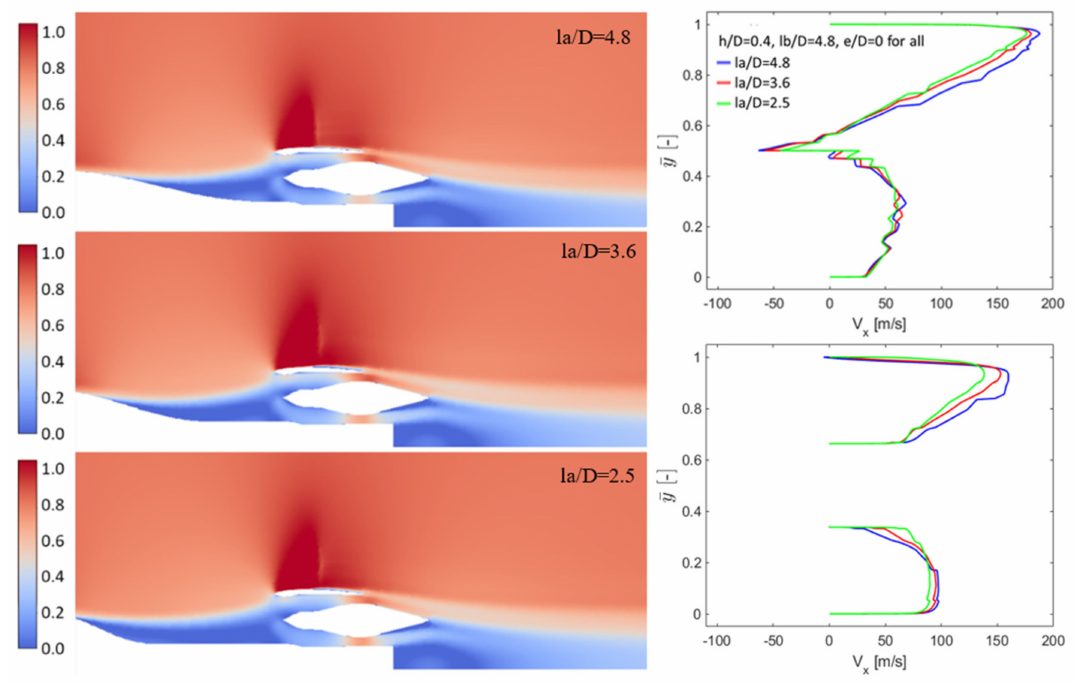
Figure 9. Contours of Mach number. Results of varying intake diffusion lengths l a , 2D simulation.